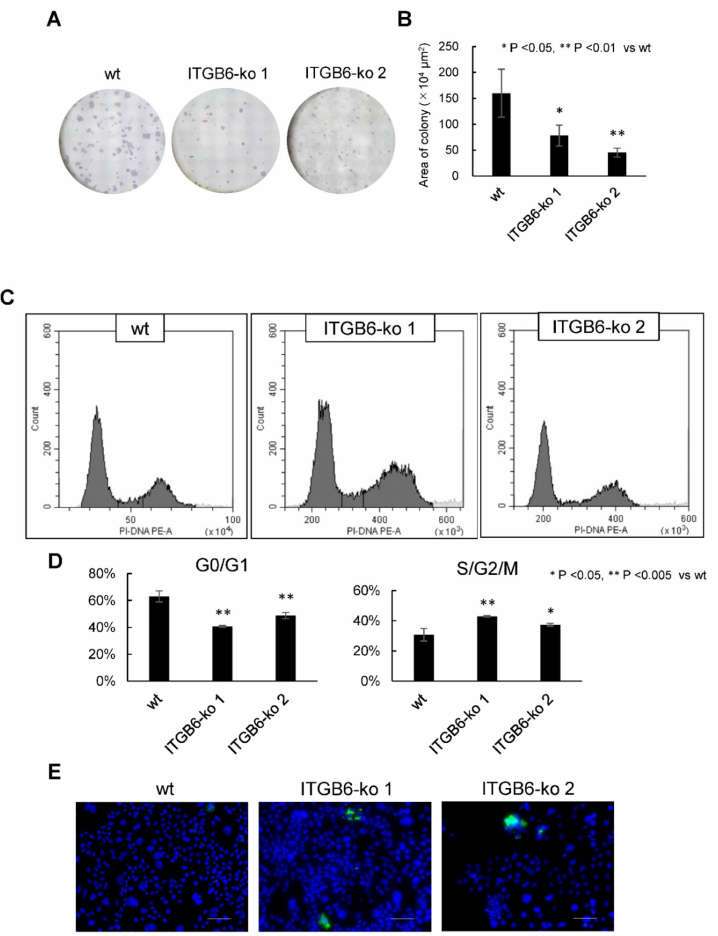
Figure 3. Integrin β 6-knockout ( ITGB6 -ko) affected colony formation and cell cycle progression. ( A ) Colonies were stained with crystal violet. ( B ) The ITGB6 -ko cells colonies covered significantly less surface area than the wild-type (wt) cell colonies. ( C ) Representative histograms of cell distribution in each cell cycle phase determined by flow cytometry. ( D ) The number of cells in G0/G1 was lower in ITGB6 -ko cells than in wt cells, whereas the number of cells in S/G2/M was increased in ITGB6 -ko cells. All experiments were performed in triplicate. ( E ). Cleaved caspase-3 immunofluorescence was observed in ITGB6 -ko cells, while not in wild-type cells. DAPI was used to stain nucleus. Green and blue signals indicate cleaved caspase-3 and nucleus